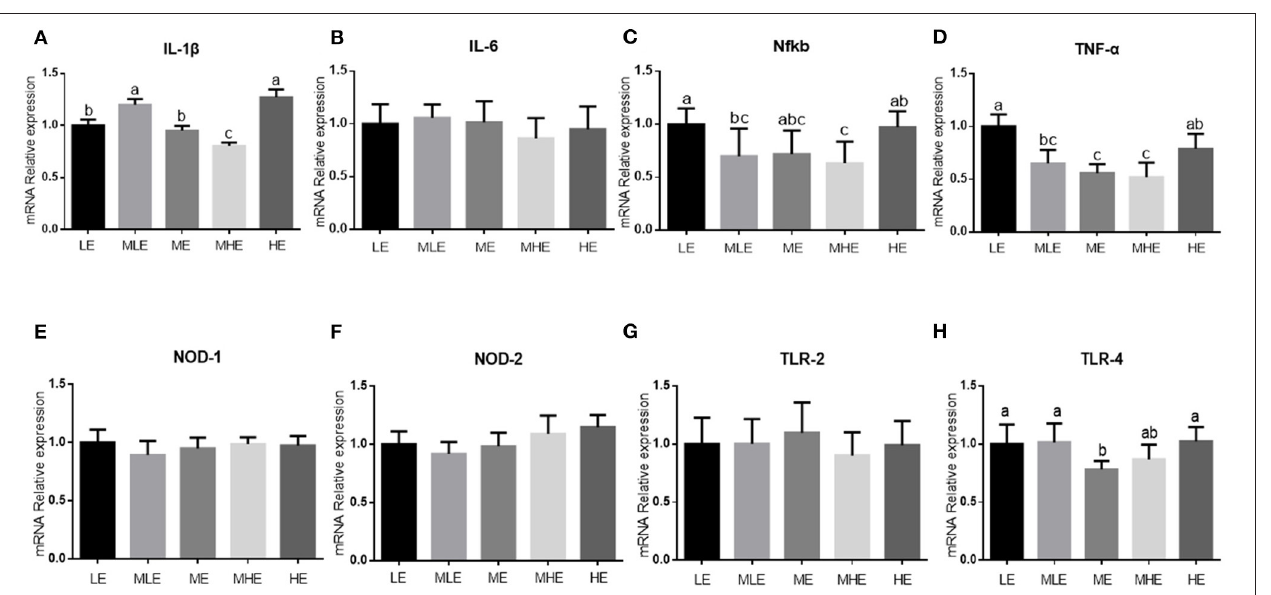
ME groups were significantly higher than those in the remaining three groups ( p < 0.05). in Supplementary Figure 1 , the